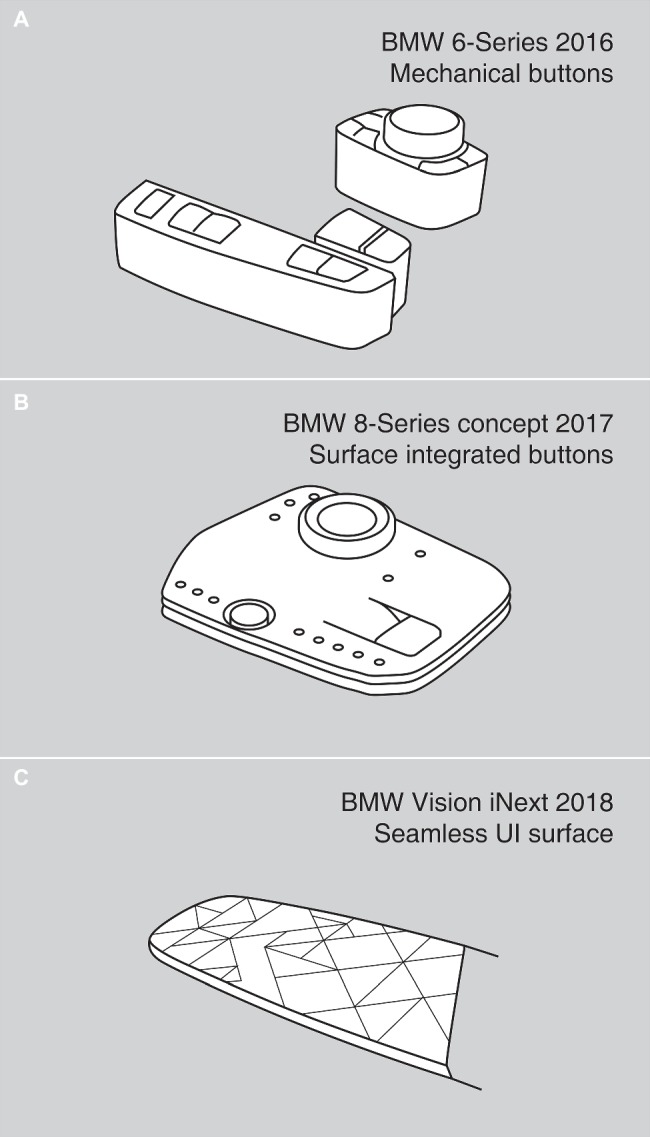
Exemplified depiction of the shift from (A) mechanical buttons (BMW Group, 2015) through (B) surface-integrated buttons (BMW Group, 2017) to (C) seamlessly integrated UI-surfaces (BMW Group, 2018).